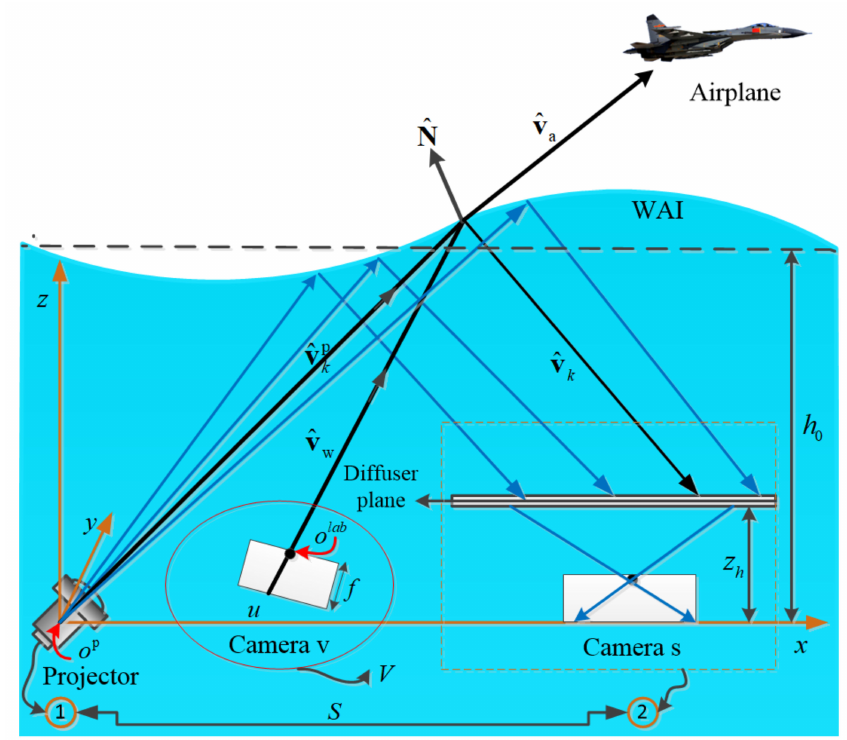
Figure 4. Geometry of the image restoration model via structured light projection, comprising a structured light projection system S and an observing system V , where component S includes a projector, diffuser plane and